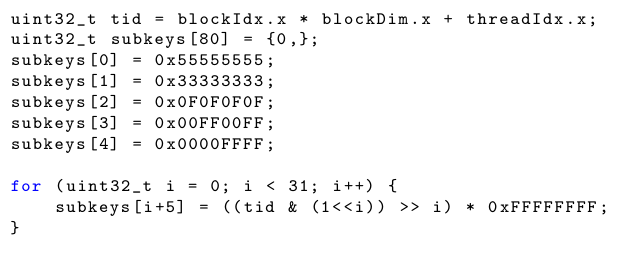
553.932 Gbps, 529.952 Gbps, 583.859 Gbps, and 214.284 Gbps, respectively.